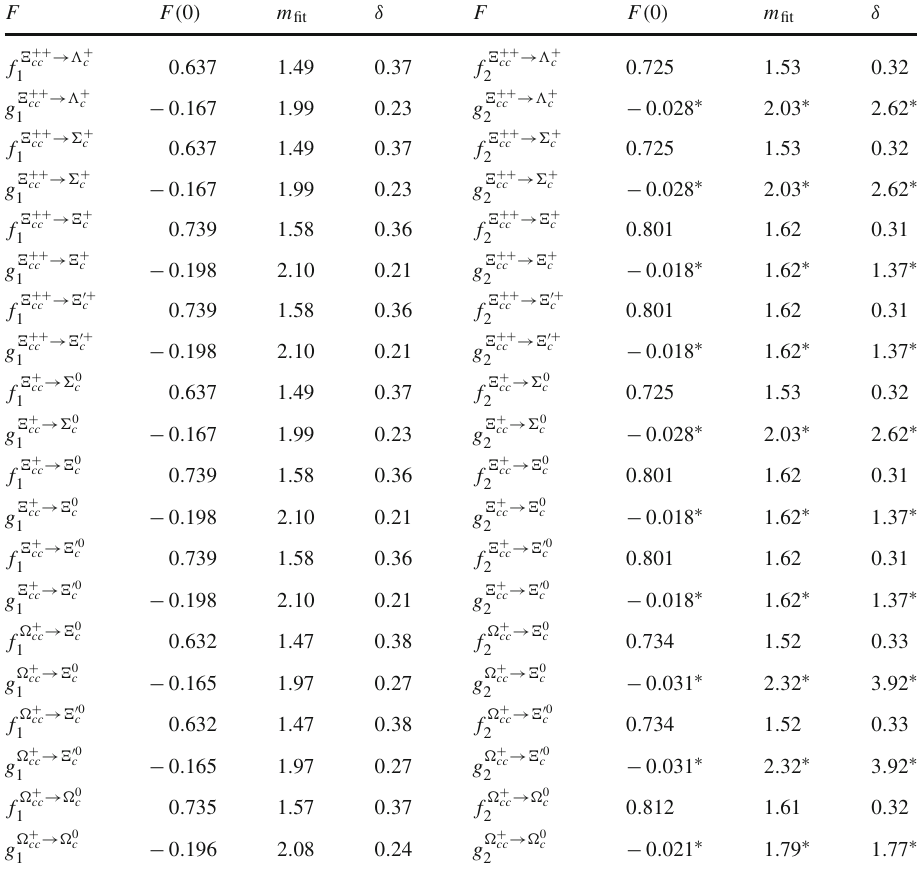
of doubly charmed baryon decays with the axial vector ( 1 + ) diquarks. The formula